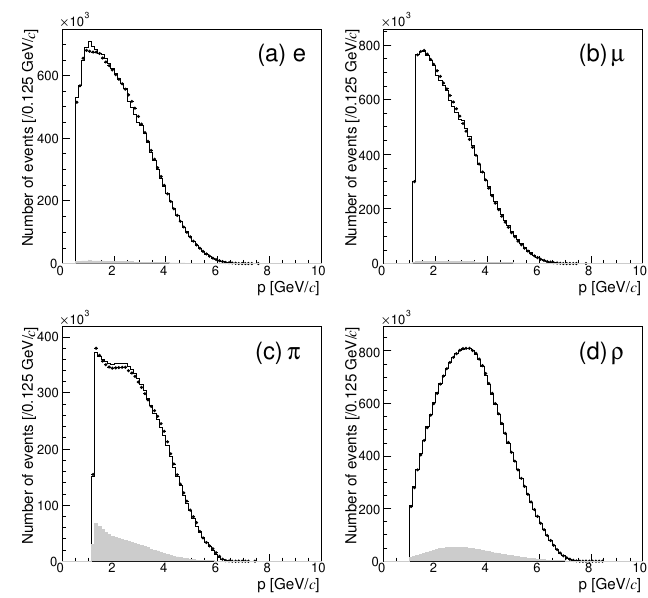
Figure 1 . Momentum distributions of (a) electrons, (b) muons, (c) pions, and (d) ρ mesons for the samples obtained after all event selections in each mode. The points with error bars are the data, the solid histograms are the MC expectation, and the gray shaded histograms are the contribution from misidentification for each particle species.